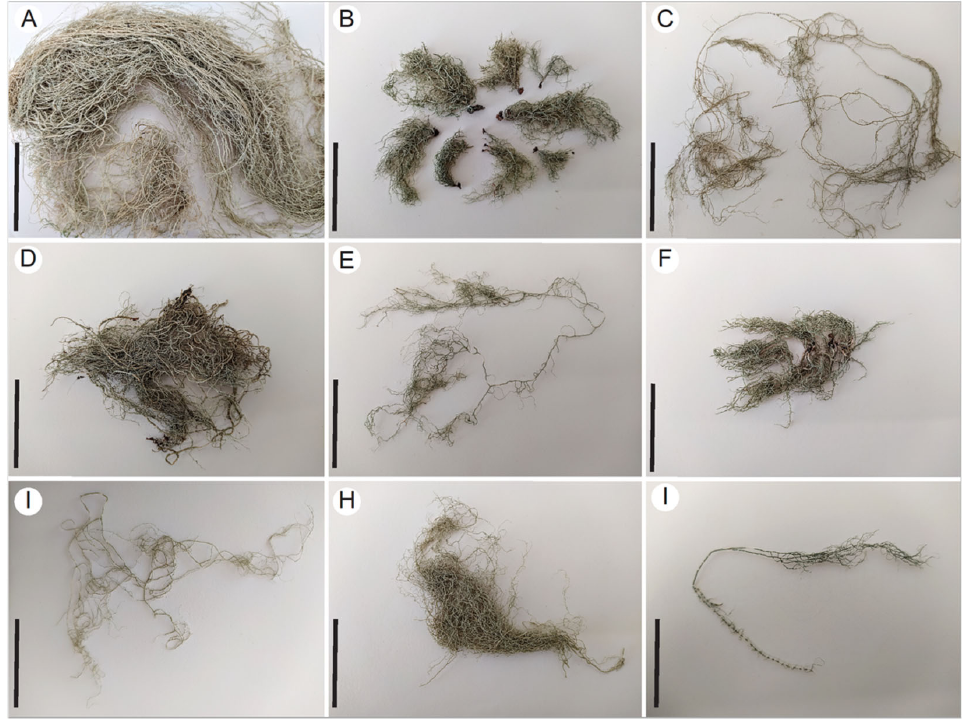
Figure 3. Photos of representative Usnea specimens collected at “Geyser Pass 1” site. Usnea cavernosa (panel ‘A’), was the most common Usnea species sampled in the study. Scale bar = 3 cm (photo credit: S. Leavitt).